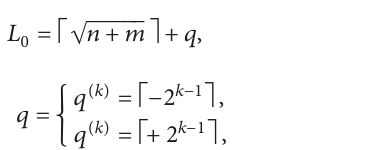
Table 1: The common hidden layer activation functions of ELM. Types of activation Formula of activation functions